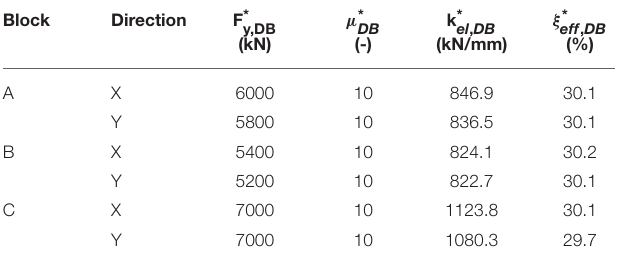
TABLE 4 | Equivalent SDOF design parameters of the DB system for the three blocks of “Piastra” buiding. Block